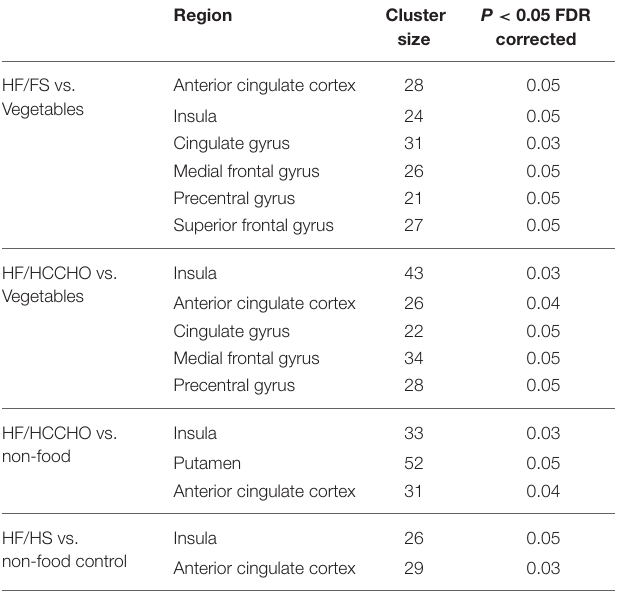
TABLE 4 | Regions showing brain activations in response to viewing food photos. Coordinates of regions are shown in Appendix C (Supplementary Material). P < 0.05 FDR Region Cluster size corrected HF/FS vs.